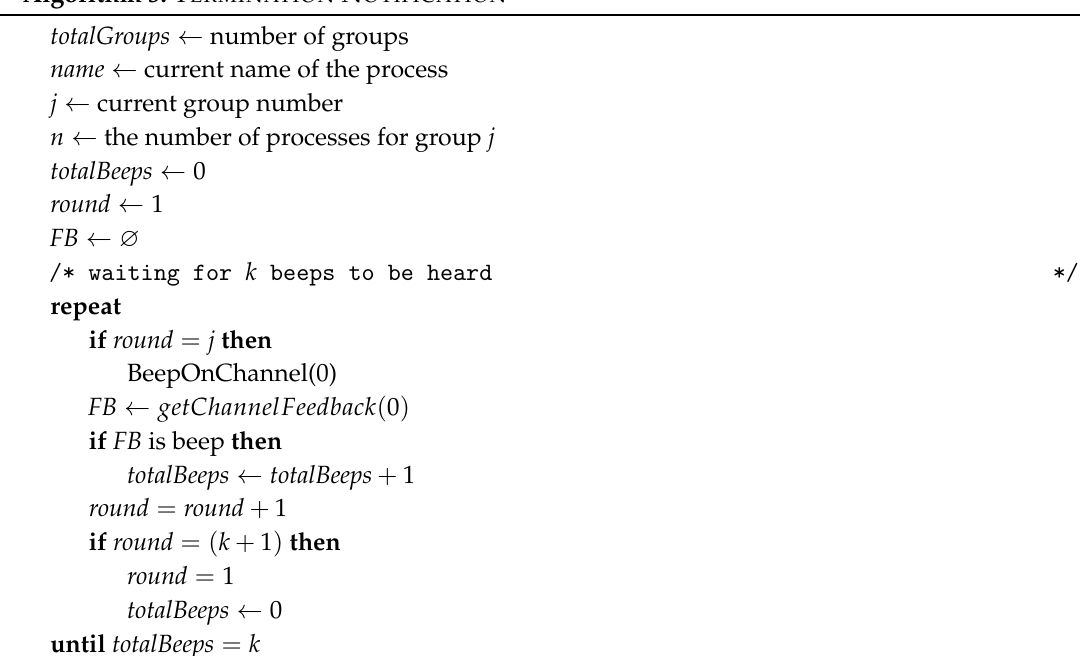
Algorithm 3: T ERMINATION N